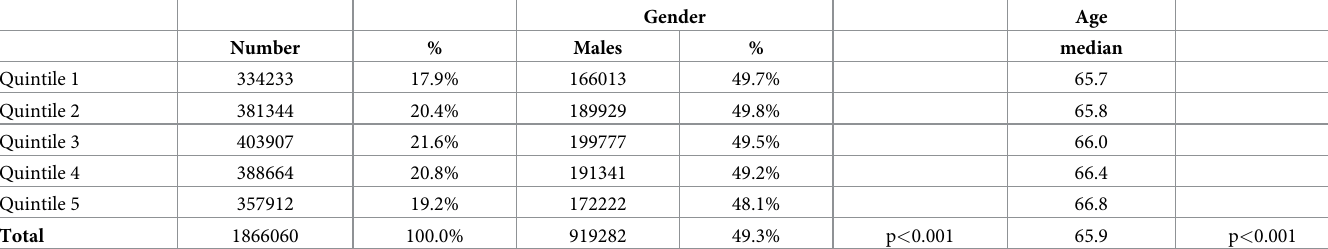
Table 1. Descriptive of the number, age and gender distribution of the invitees in each quintile. Quintile 1 least deprived, Quintile 5 most deprived.